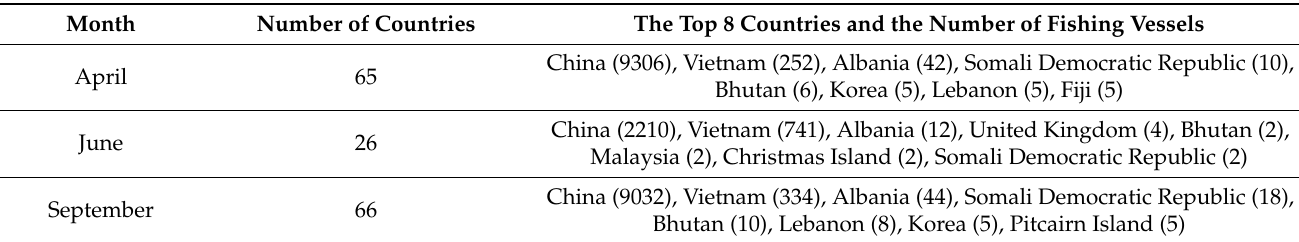
Table 8. Statistical results of countries of fishing vessels in the northern South China Sea. The Top 8 Countries and the Number of Fishing